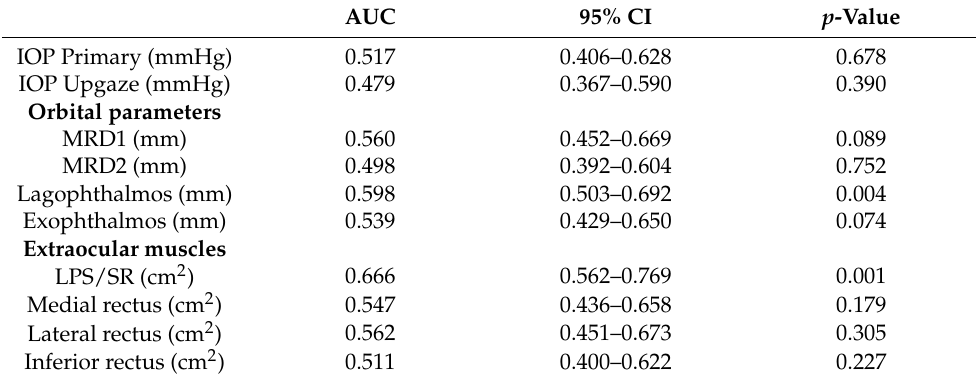
Table 4. Receiver operating characteristic (ROC) curve analysis of TAO eyes (N = 106).